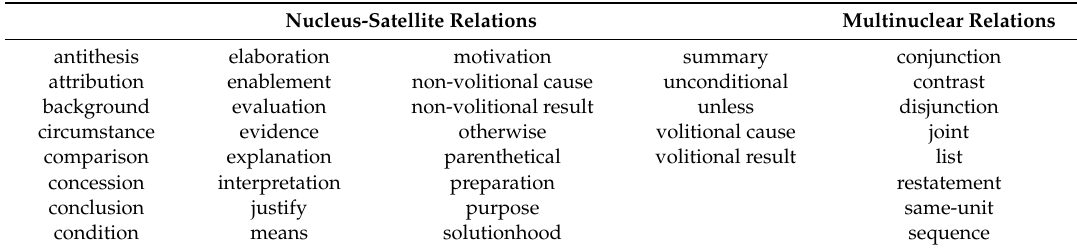
Table 2. Relation set used in the manual annotation of the book reviews corpus.